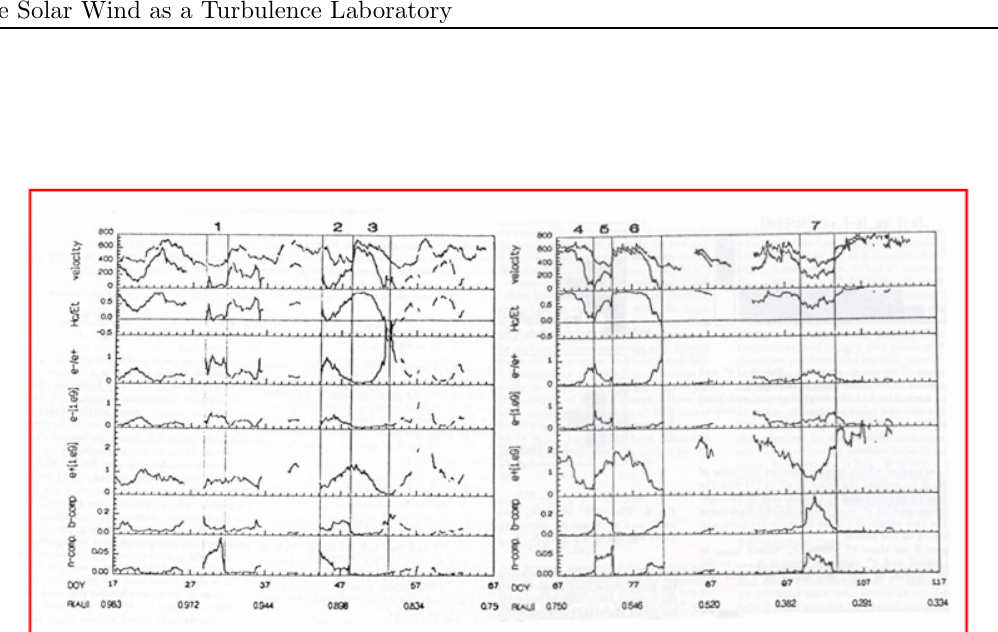
Figure 45: Upper panel: solar wind speed and solar wind speed multiplied by 𝜎 c . In the lower panels the authors reported: 𝜎 c , 𝑟 E , e – , e + , magnetic compression, and number density compression, respectively. Image reproduced by permission from Bruno and Bavassano (1991), copyright by AGU.